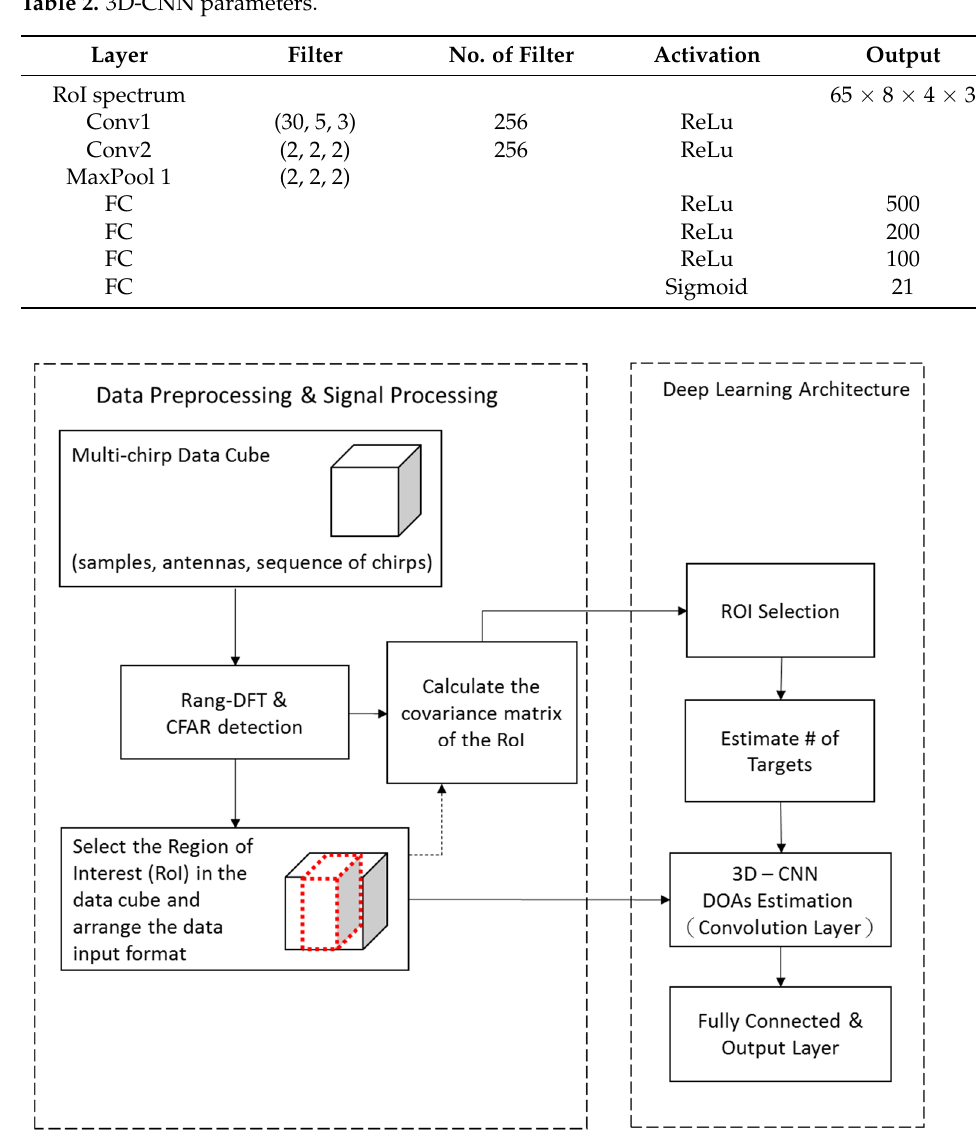
Figure 4. Signal processing and deep learning architecture.